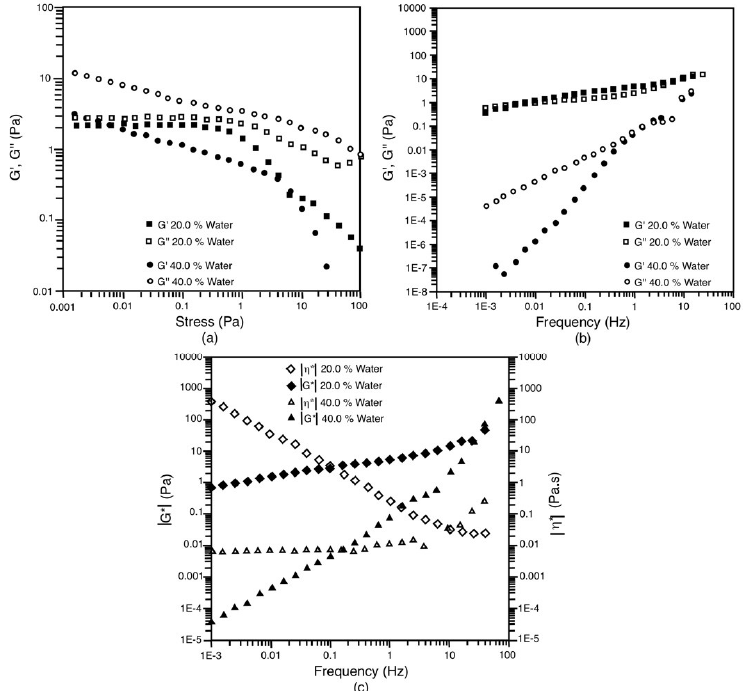
Figure 11. Oscillatory tests for the liquid crystal extracted from the system on the dilution line S/O = 25/75 at 30 °C. ( a ) Amplitude shear stress sweep at 1 Hz; ( b ) Frequency sweep at 0.1 Pa; ( c ) Evolution of |G*| and | η *| against frequency.